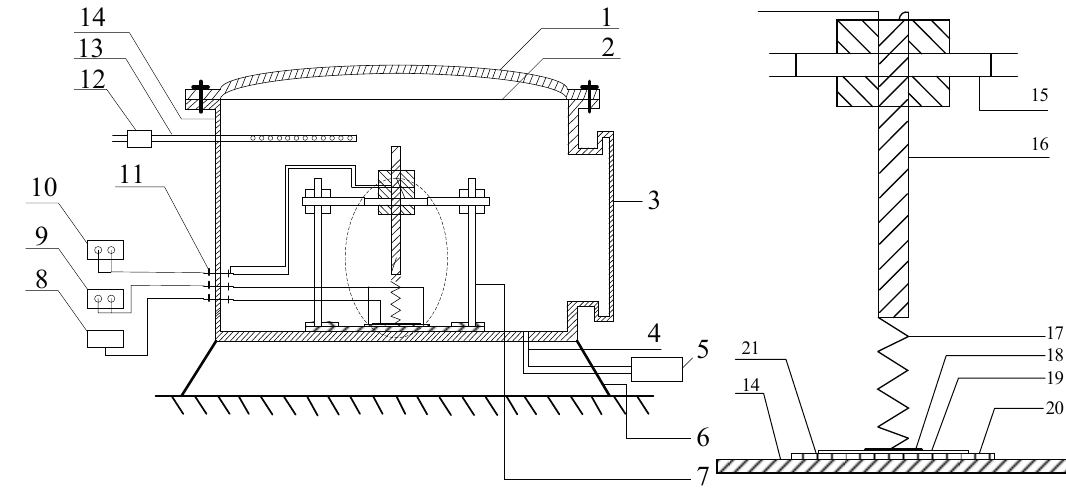
Figure 8. Schematic diagram of the gas